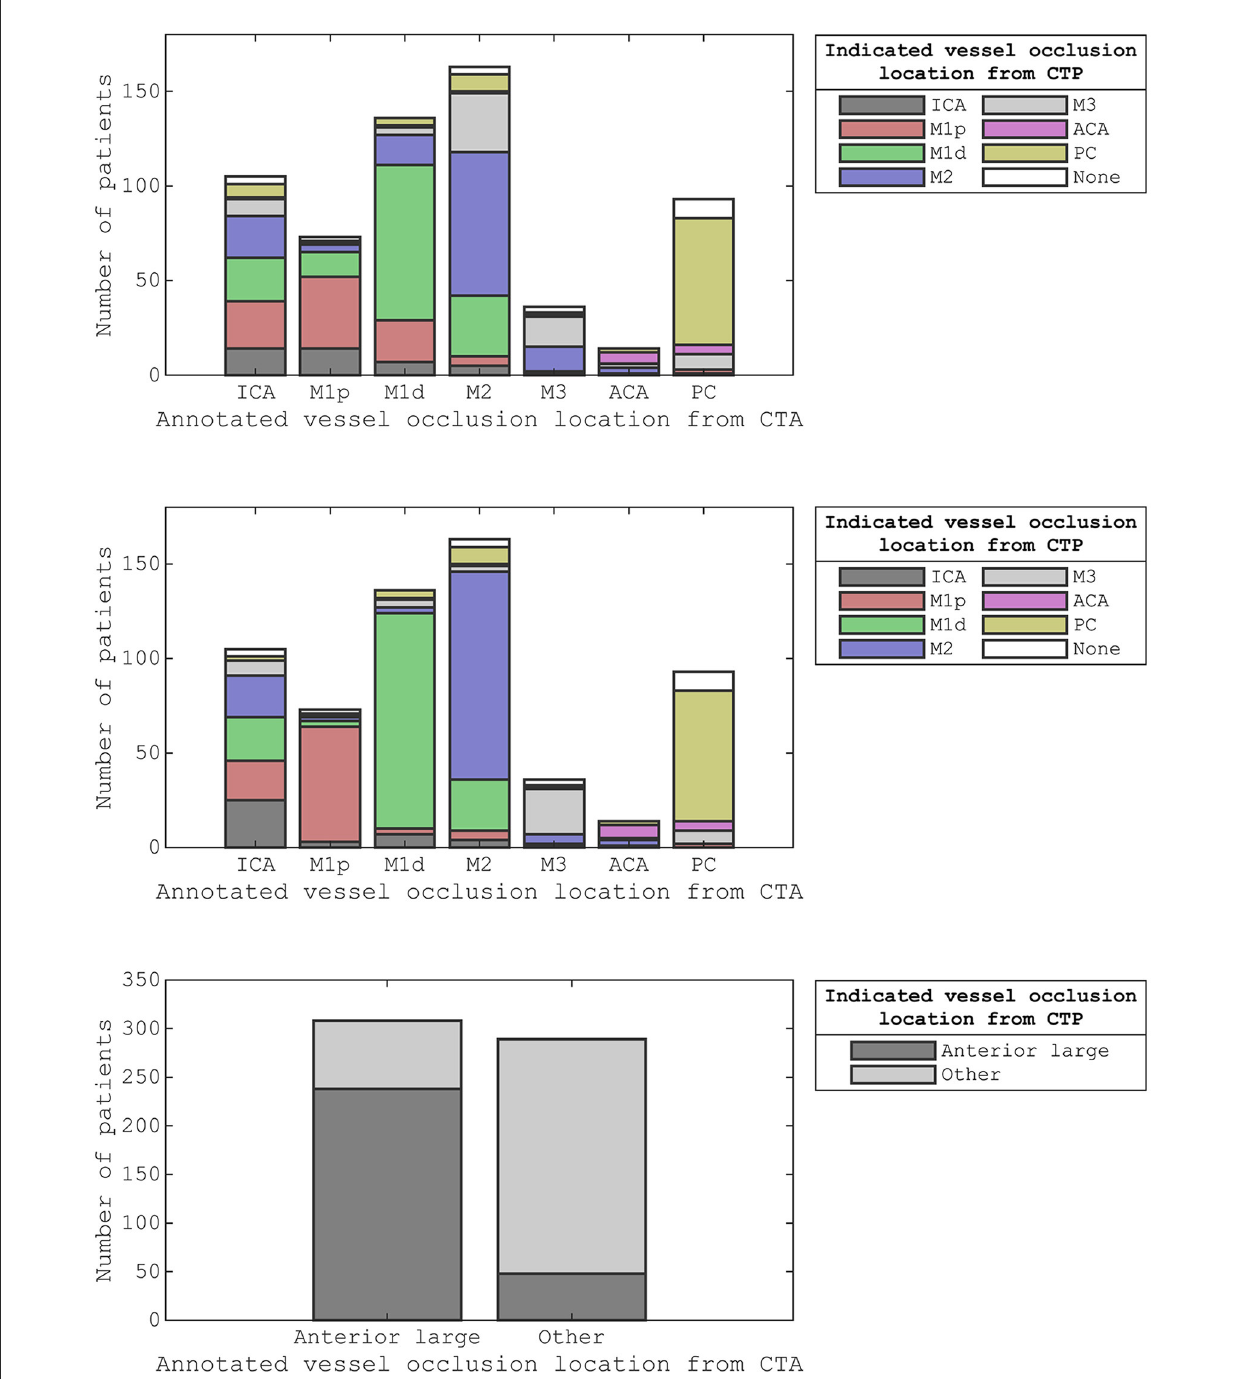
FIGURE6 The stacked bar graphs for the confusion matrices from Table 2 (top), Table 4 (middle), and Table 5 (bottom). We considered the annotated vessel occlusion locations from CT angiography as the reference class and the indicated vessel occlusion locations from CT perfusion as the predicted class. For the middle-stacked bar graph, we allowed the second-best indication to also count as correct. For the bottom stacked bar graph, we dichotomized the vessel occlusion locations into anterior large vessel occlusions and other vessel